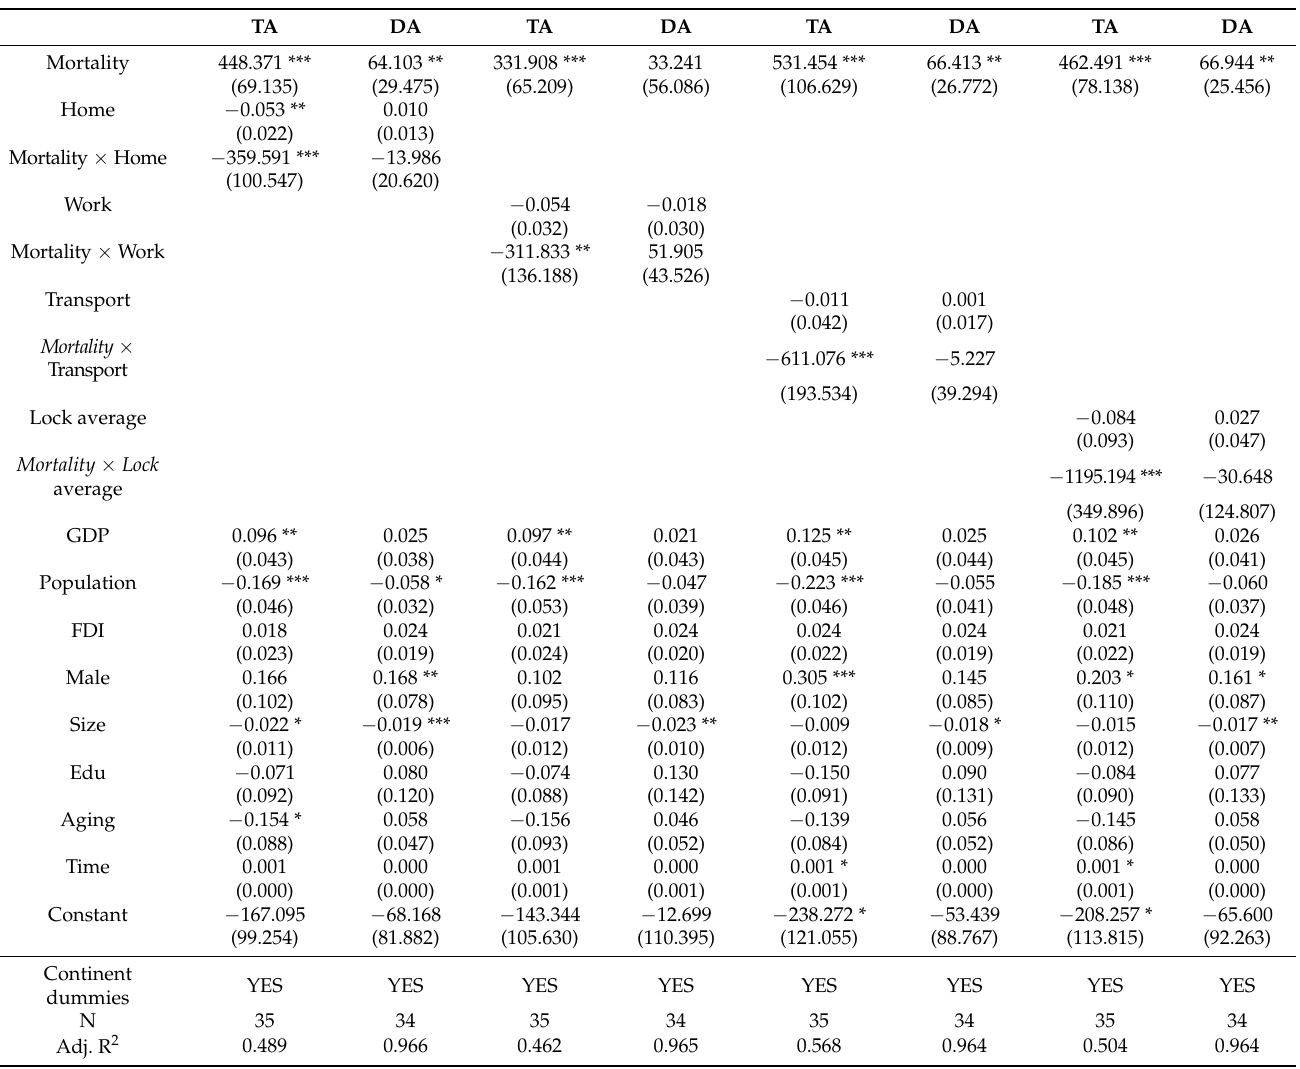
Table 5. The robust OLS regression results by adding the lockdown